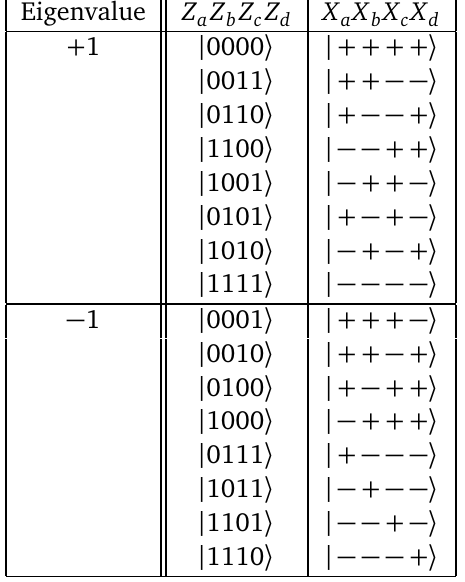
Z Z Z and X a b c d